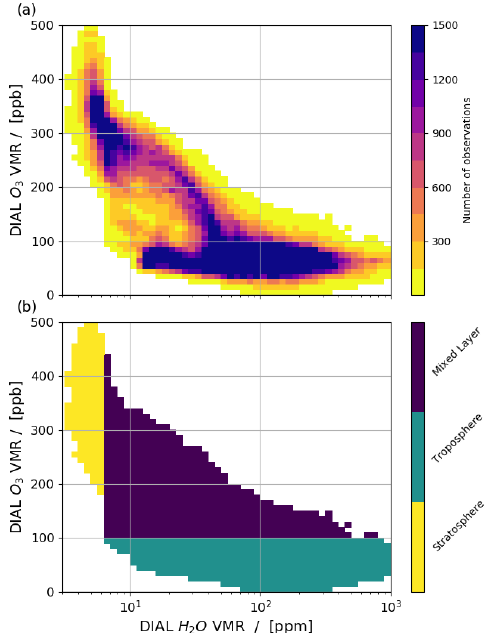
Figure 12. Binned distribution of water vapour and ozone observa- Figure 11. Binned distribution of water vapour and ozone obser- tions in T–T space as in Fig. 11 but coloured by bin-average (a) hu- vations in T–T space for four WISE flights coloured by bin-average midity bias and (b) tropopause-relative (a) number of DIAL observations and (b) type of classified air mass < 100ppb and VMR H > 6.5ppm), with troposphere (VMR O 3 2 O > 100ppb and VMR H > 6.5ppm), and mixed air (VMR O 3 2 O stratosphere ( > 100ppb VMR O and < 6 . 5ppm VMR H ). Bin 3 2 O sizes are 10ppb for VMR O and 0.05ppm for log 10 (VMR H ). 3 2 O